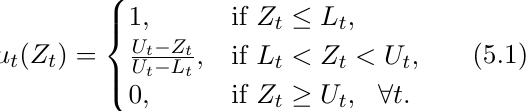
Table 1. The shipping/damage